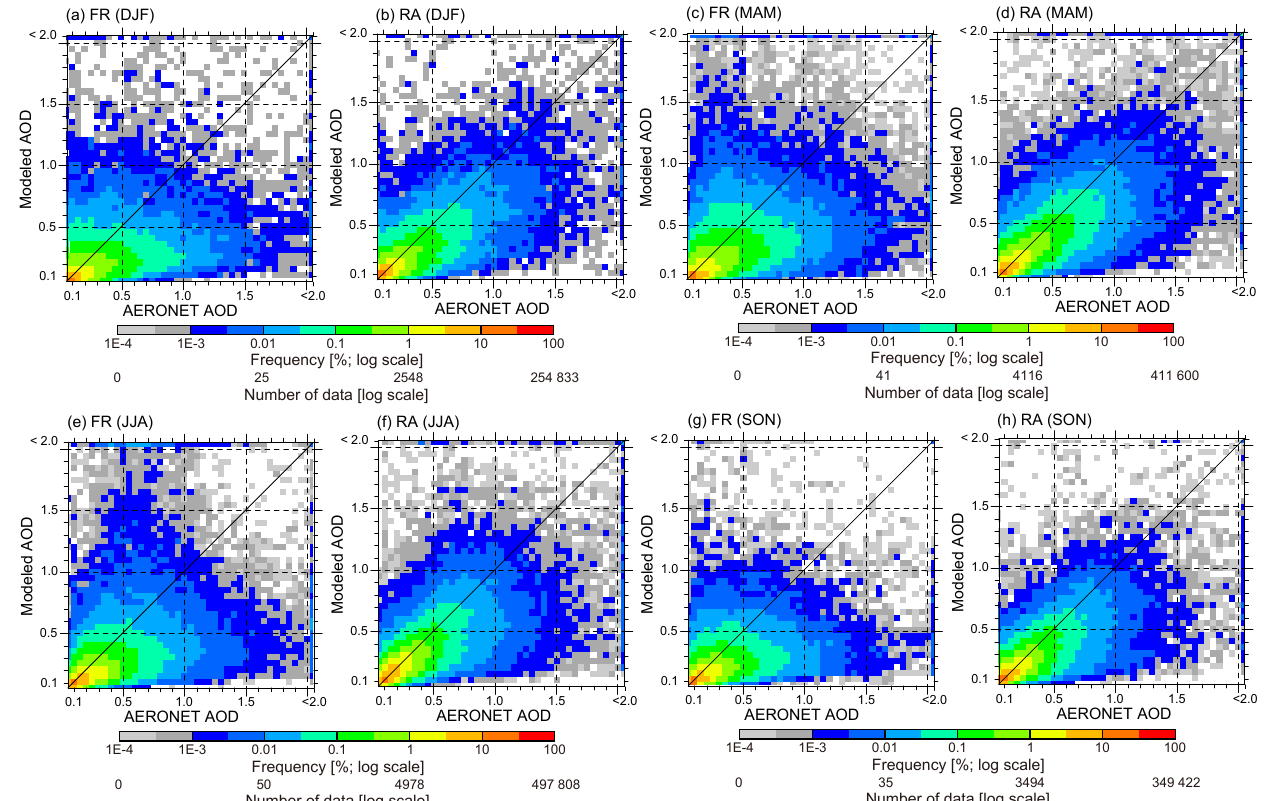
Figure 12. The same as Fig. 11, except for boreal (a–b) winter (December–February), (c–d) spring (March–May), (e–f) summer (June– August), and (g–h) autumn (September–November).